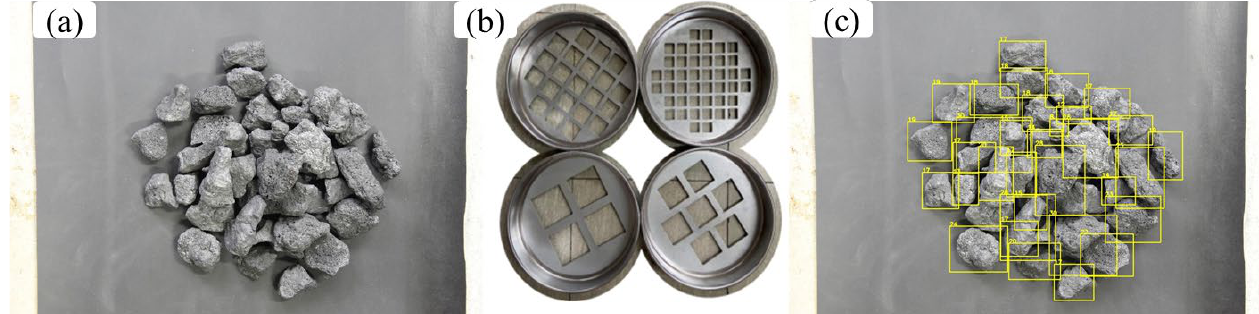
Figure 13. Example of a coke image. ( a ) Coke image; ( b ) Square hole sieves; ( c ) Detection sizes of coke particles.